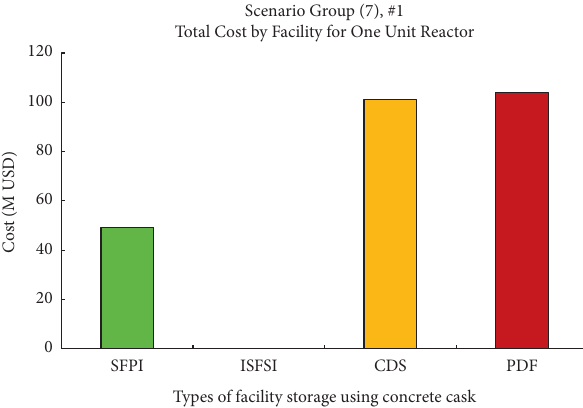
Figure 12: Breakdown of costs for all facility storages utilizing concrete